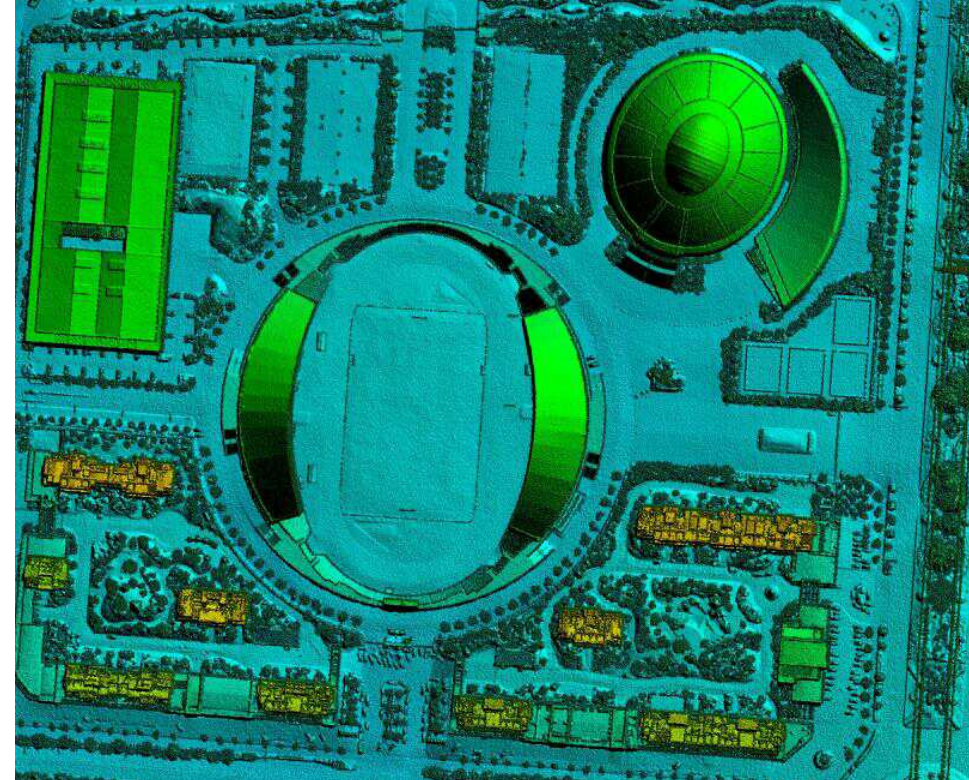
Figure 1. A digital elevation model diagram.